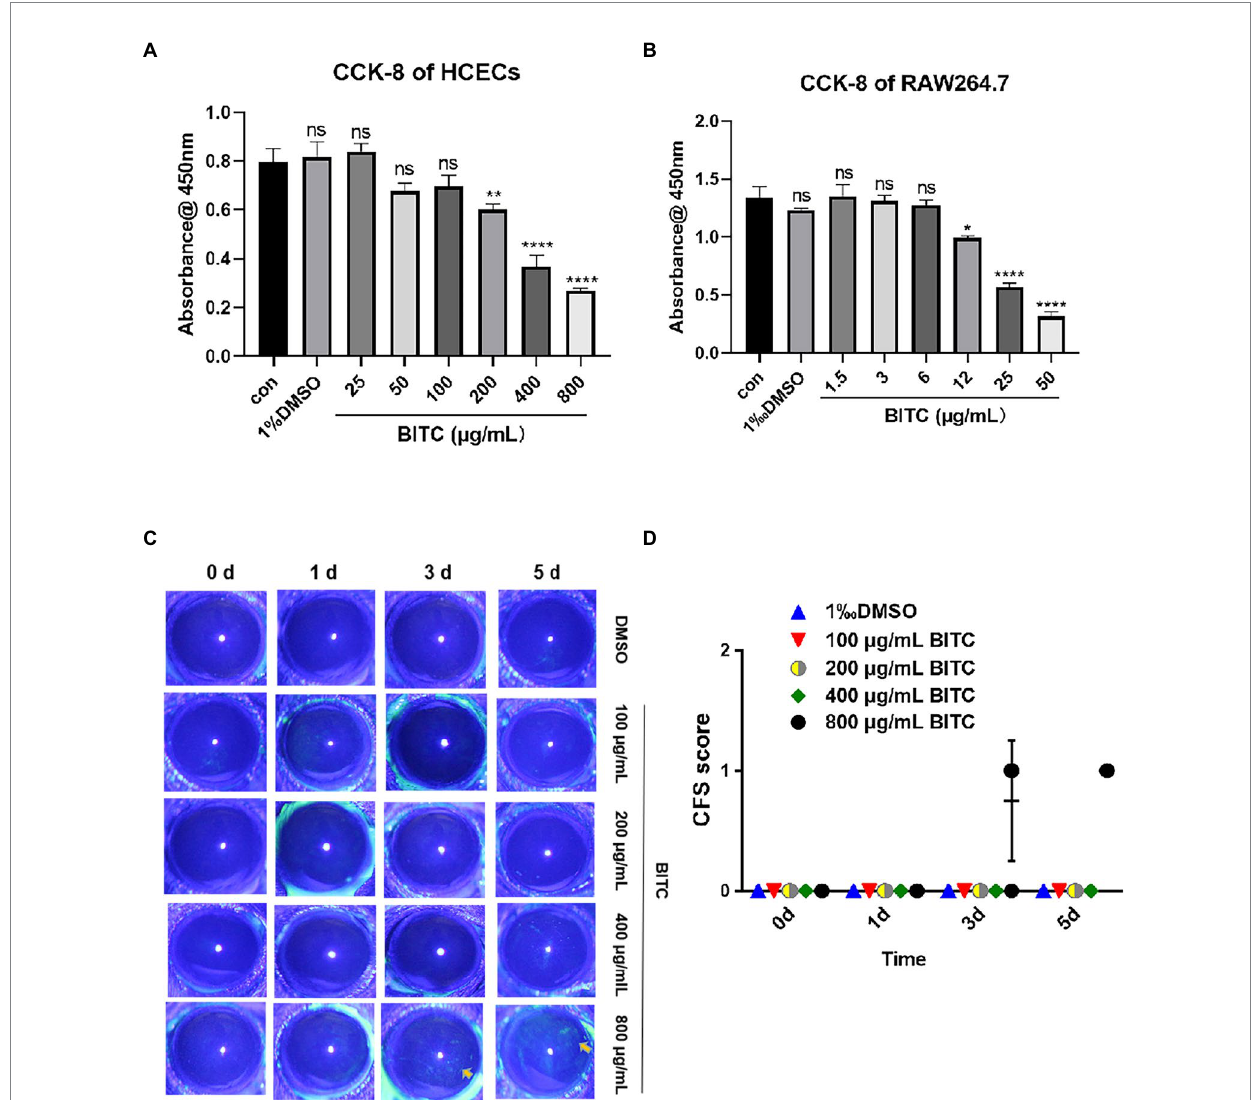
FIGURE 1 Safety of different concentrations of BITC on host cells and cornea. Cell viability of HCECs (A) and RAW264.7 (B) after treatment by BITC at different concentrations for 24 h. Toxicity to mice cornea were evaluate by CFS (C) and CFS scores (D) . Values represent as means ± SD (* p < 0.05, ** p < 0.01, *** p < 0.001, **** p <